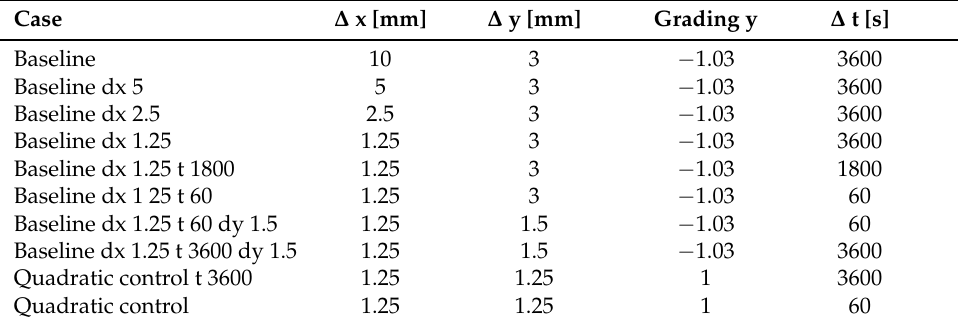
Table A1. Discretizations used in grid refinement